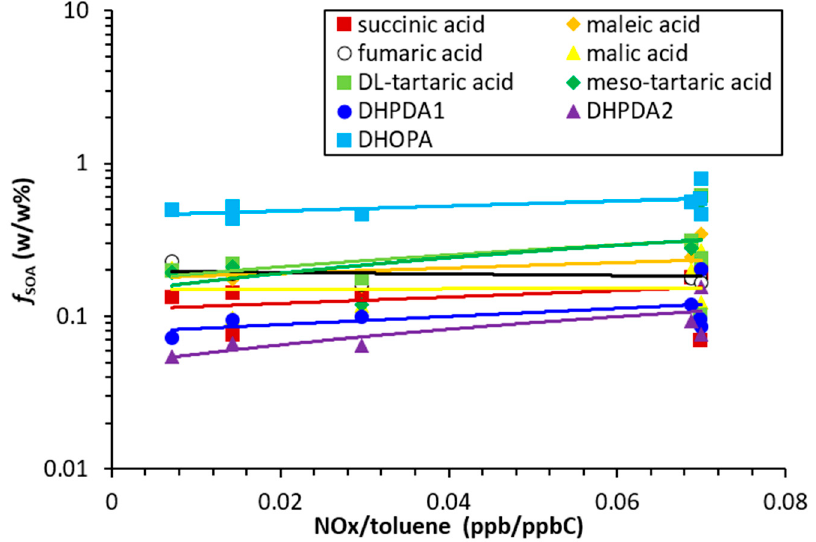
Figure 4. Ratio of tracers to total SOA mass ( f SOA ) observed in experiments with toluene as a function of NO x /toluene ratio.